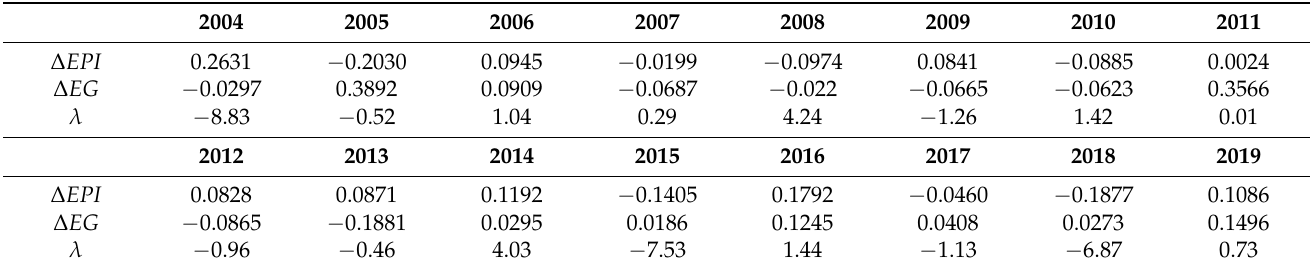
Table 4. The result of ∆ EPI , ∆ EG , and λ for the sample city